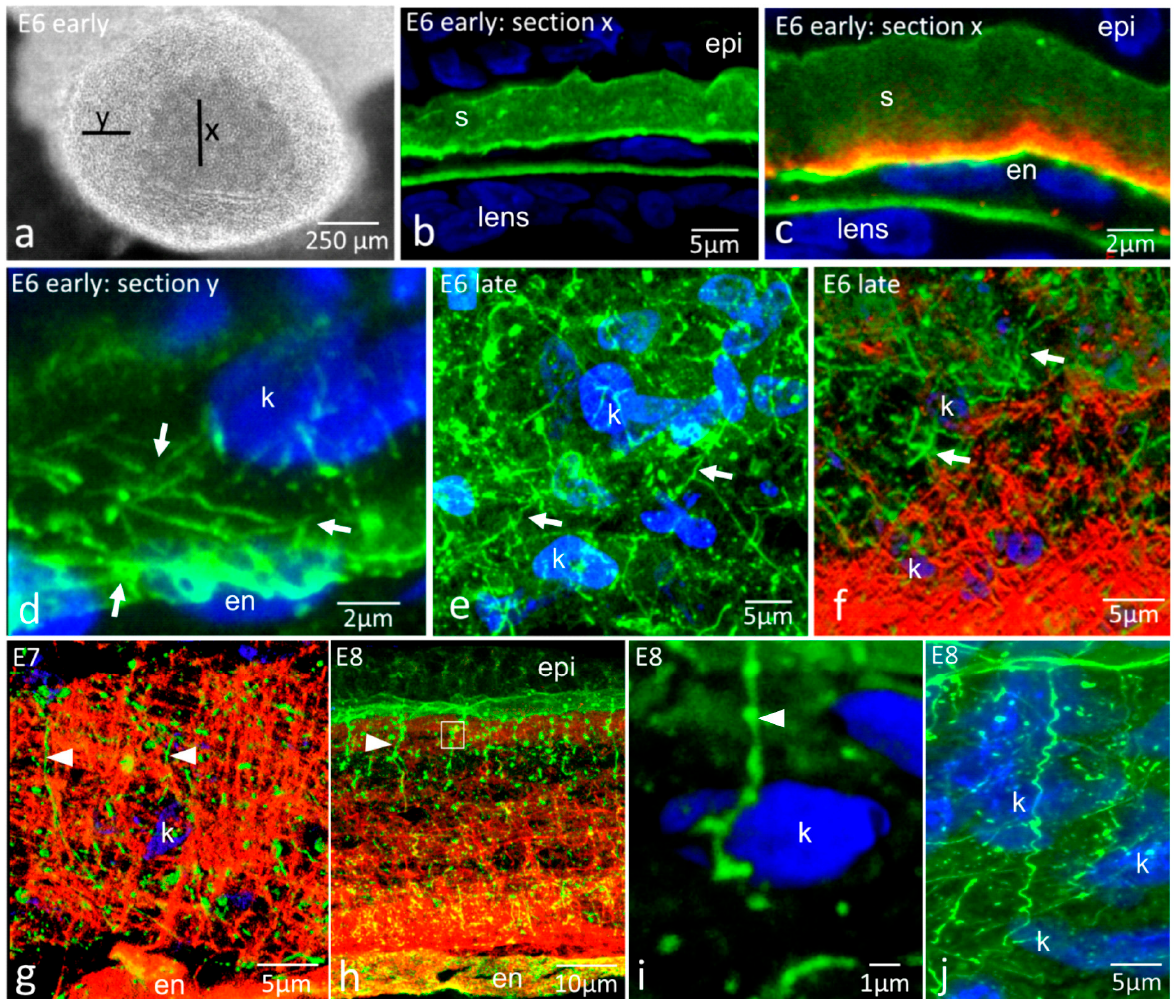
Figure 1. Immunohistochemistry for fibronectin (green) and tenascin-C (red) in early development and morphogenesis of the corneal stroma (E6–E8), demonstrating two distinct ECM glycoprotein networks. S, stroma; epi, epithelium; en, endothelium; k, keratocyte nucleus. ( a ) Whole-mount face-on view of early E6 cornea. Lines X and Y indicate the positions of corneal transverse sections shown in Figure 1b–d. Section X is central, and keratocytes have not yet populated the primary stroma—endothelial cells